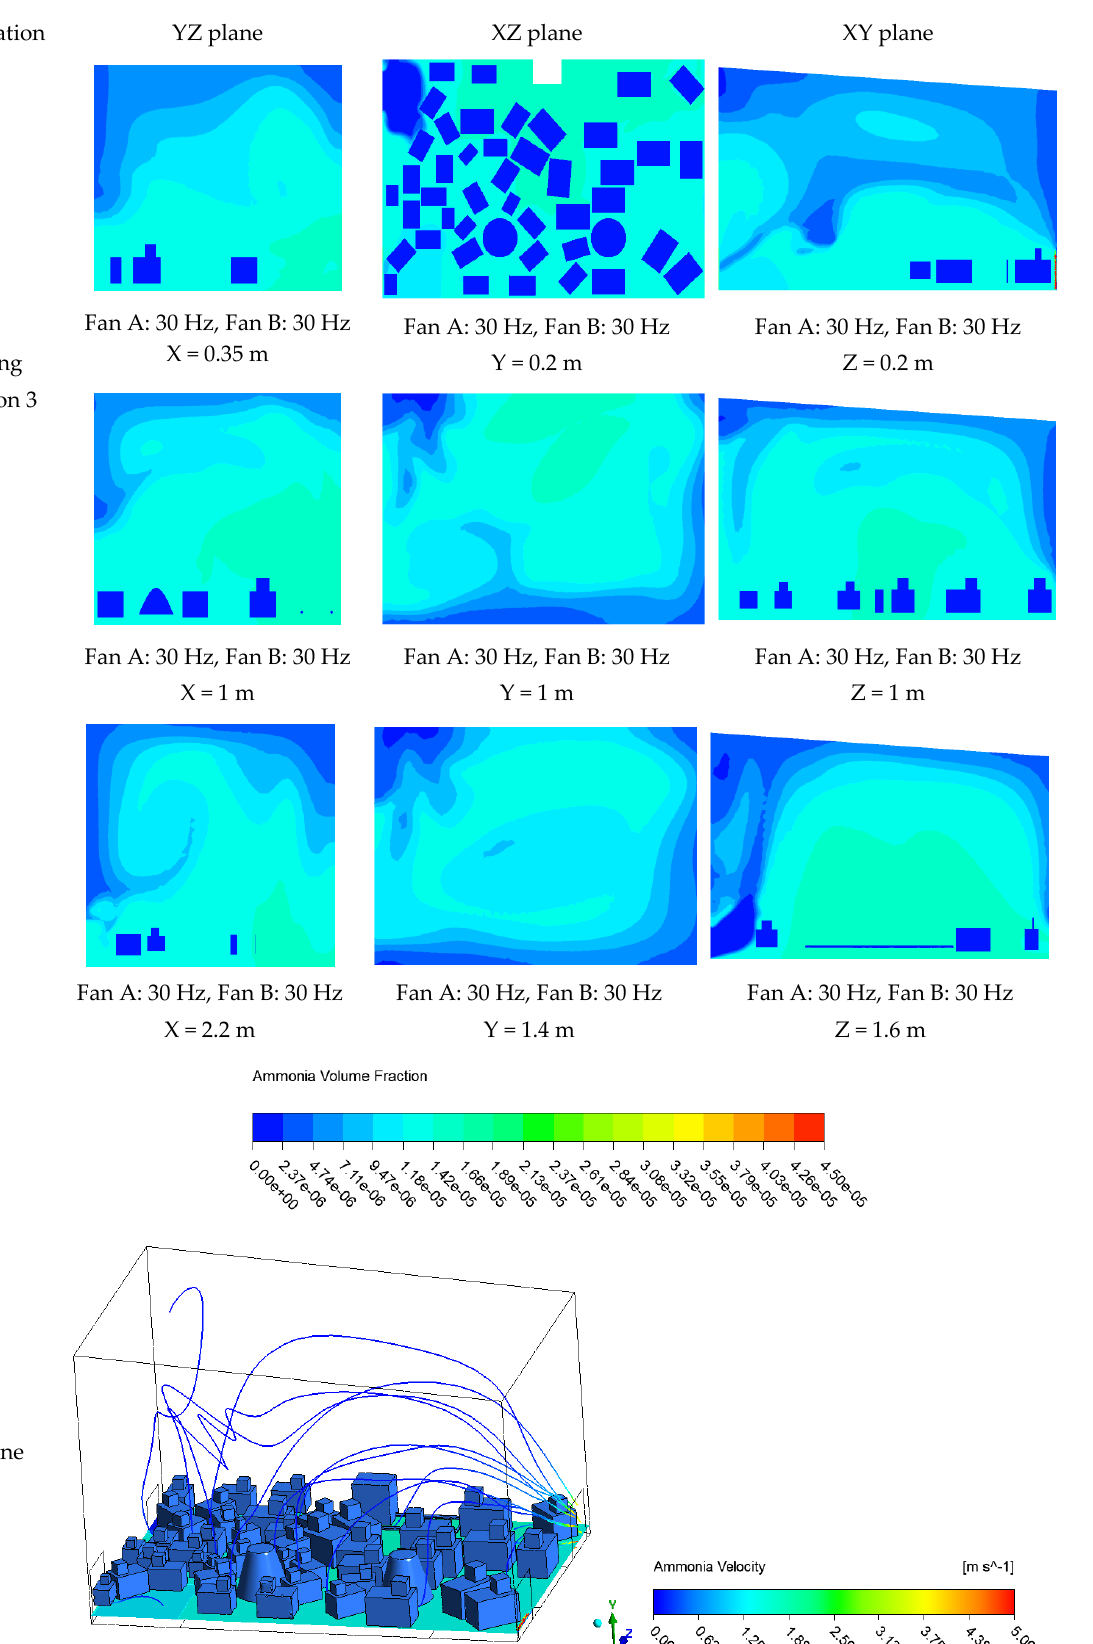
Figure 10. Simulation results of ammonia concentration distribution under working condition 2.